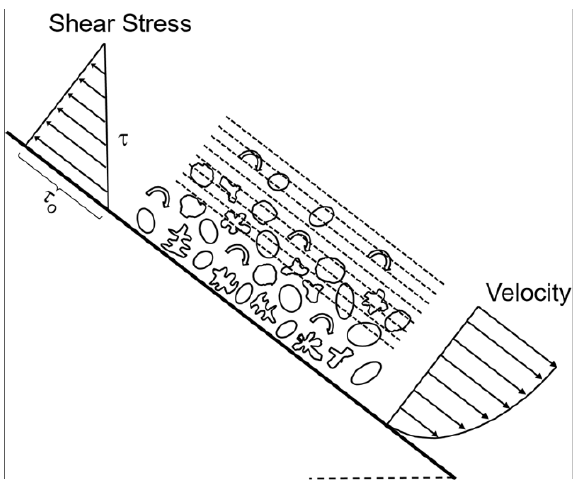
Figure 21. The shear stress and velocity distribution and the schematic of the microstructural development during melt flow over the inclined surface. Reprinted with permission from Ref. [210]. Copyright 2012 Springer Nature Customer Service Centre GmbH, Springer Nature.